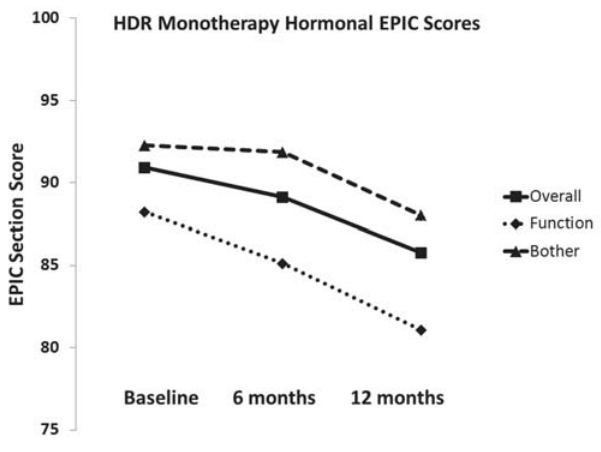
Figure 4 - EPIC hormonal overall, function, and bother scores before HDR brachytherapy monotherapy and 6 and 12 months after